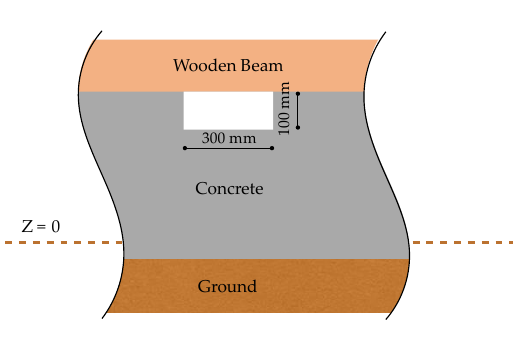
Figure 8. The section view of A-A.